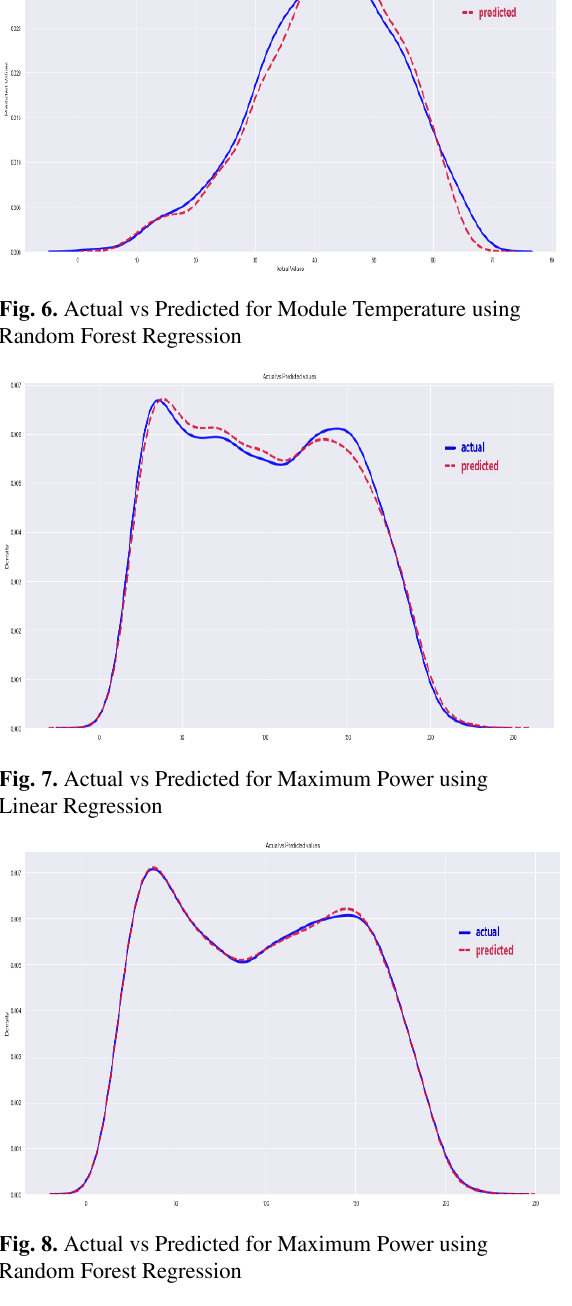
Fig. 4. Fabrication of HIT PV Cell